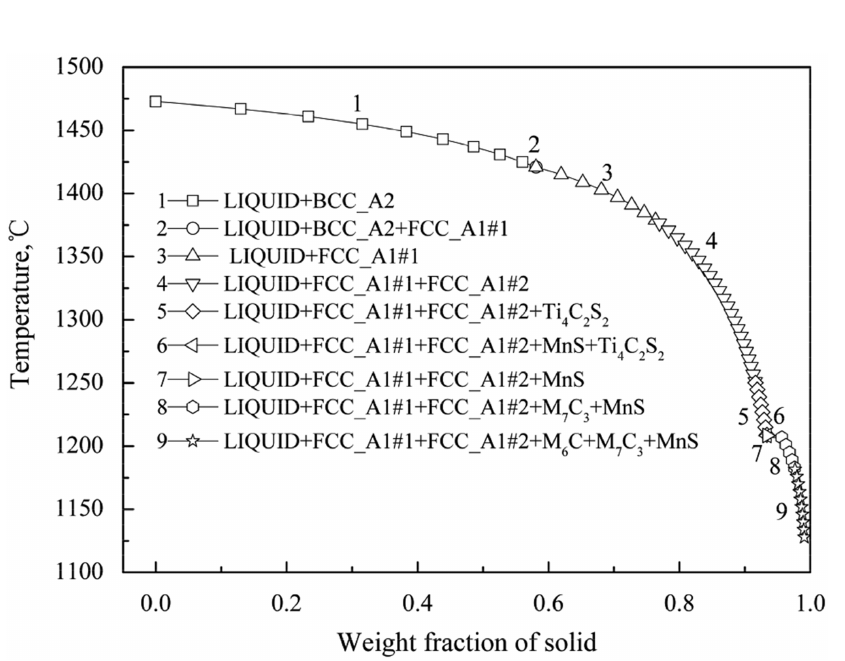
Figure 5: Temperature as a function of solid fraction during